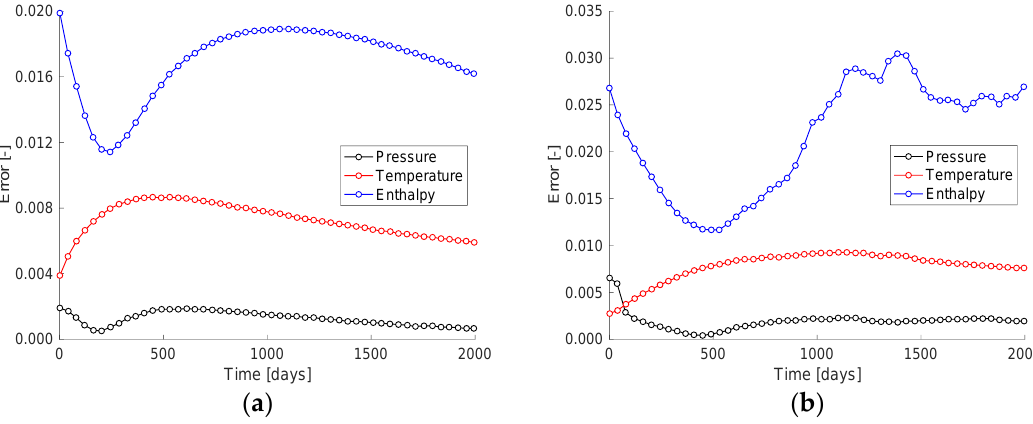
Figure 6. The formulation error for ( a ) fine-scale, and ( b ) ADM simulations.